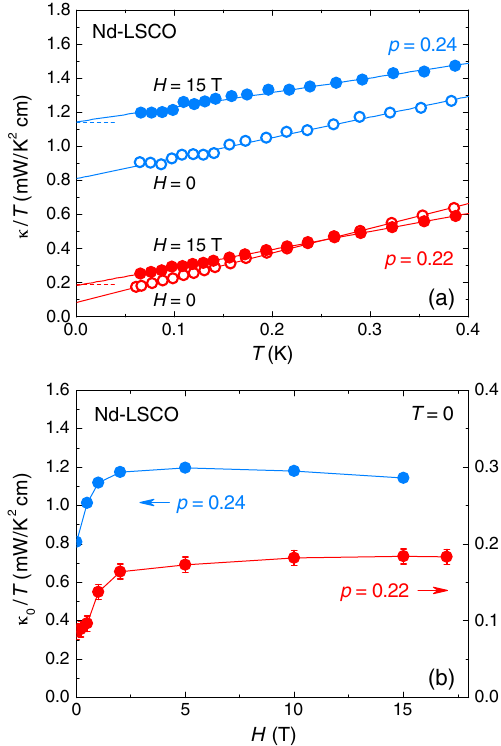
FIG. 2. (a) Thermal conductivity κ vs temperature plotted as κ =T vs T , for Nd-LSCO at p ¼ 0 . 22 (red) and 0.24 (blue), in H ¼ 0 (open symbols) and 15 T (dots). The lines are linear fits to the data over the temperature range shown. The y intercept of the fit is the residual electronic term κ 0 =T . The horizontal dashed lines are calculated from the Wiedemann-Franz law L 0 = ρ ð 0 Þ using the measured ρ ð 0 Þ (see text). (b) κ 0 =T as a function of applied magnetic field for p ¼ 0 . 22 (red) and 0.24 (blue). At both dopings, κ 0 =T saturates at high field, showing that the normal state has been reached. The error bars reflect the uncertainty on the fits shown in (a), which comes from varying the temperature range. For p ¼ 0 . 24 , the error bars are smaller than the symbols.